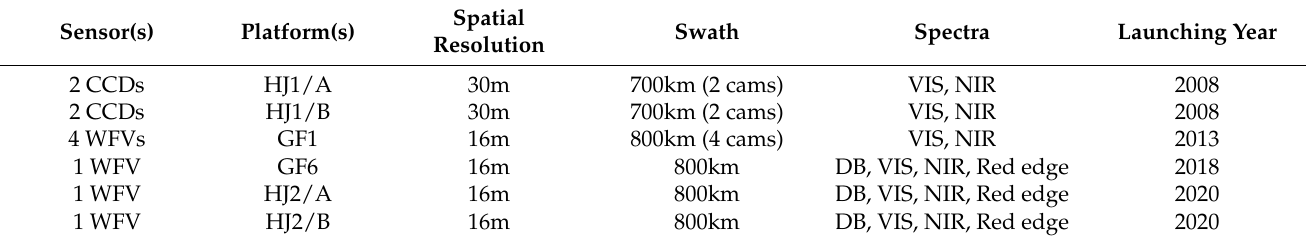
Table 1. Major Chinese satellite/sensor similar to